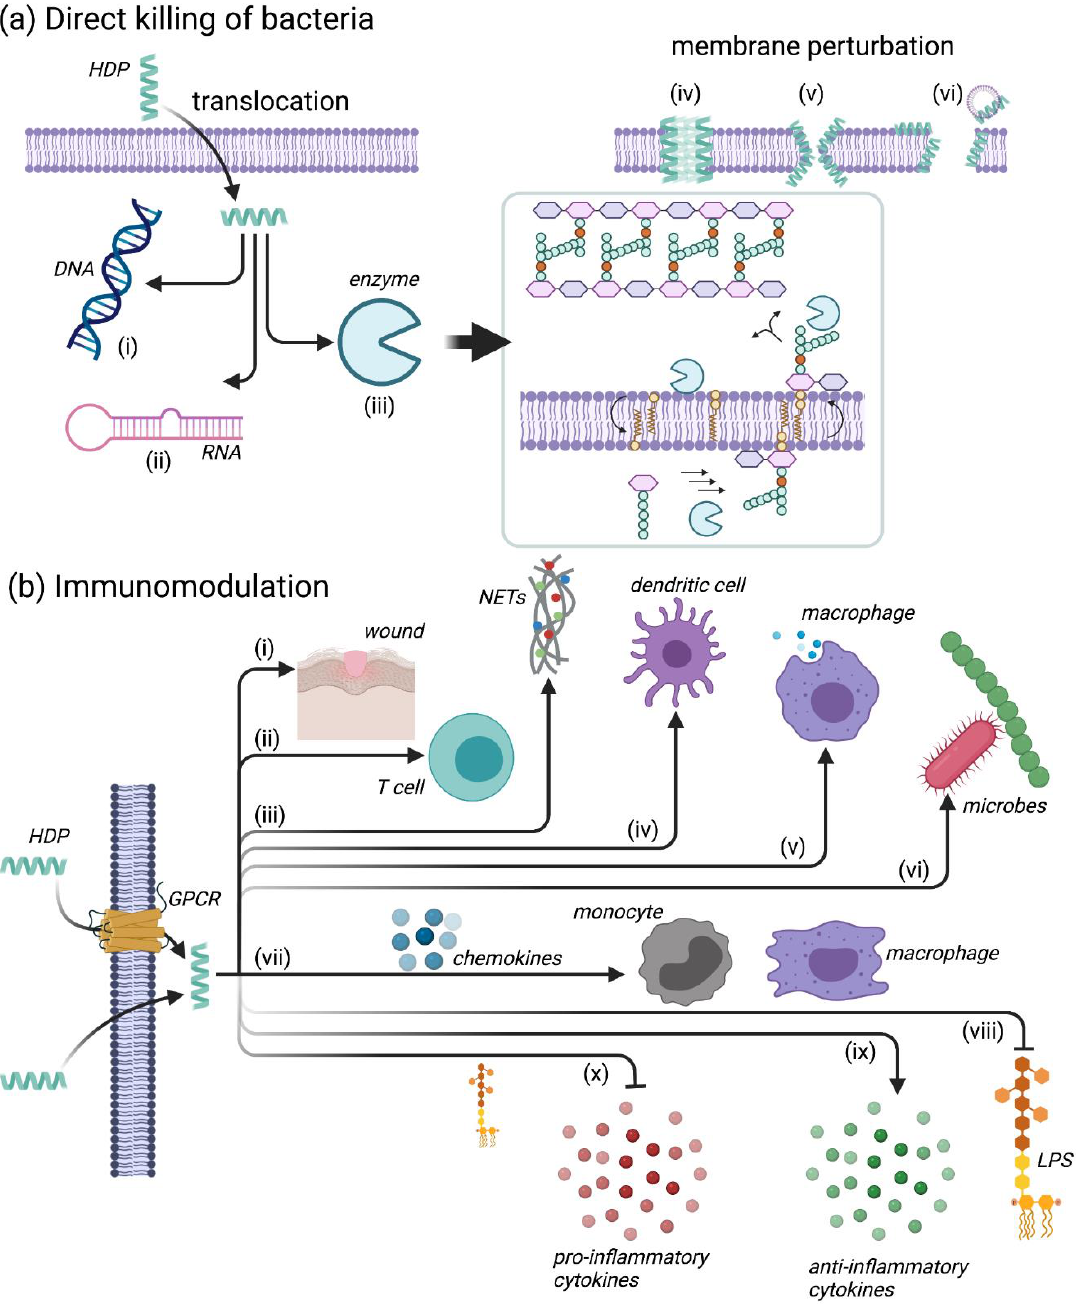
Figure 3. Mechanisms of action of HDPs: ( a ) direct killing of the bacteria, ( b ) immunomodulation. In ( a ), as indicated on the left, HDPs can translocate through the bacterial membrane to reach inner targets, such as (i) DNA, (ii) RNA or (iii) interfere with biosynthetic reactions by binding to proteins or substrates. The inset schematically shows peptidoglycan biosynthesis in S. aureus . HDPs can interfere at different points in this pathway. In ( a ), on the right, direct killing through membrane perturbation is shown. The specific mechanisms here are: (iv) barrel stave, (v) toroidal or (vi) carpet or detergent-like pore formation, which lead to cell lysis. In ( b ), intracellular uptake occurs either through G protein-coupled receptors (GPCRs) (yellow) or direct translocation [40]. Once inside, HDPs can function in a myriad of ways: (i) wound healing, (ii) recruitment and polarization of T cells, (iii) promotion of neutrophil extracellular trap (NET) release, (iv) differentiation of dendritic cells, (v) phagocytosis, (vi) modulation of the host microbiome, (vii) induction of chemokines (blue), which leads to the recruitment of monocytes (grey) and macrophages (purple), (viii) neutralization of lipopolysaccharide (LPS), (ix) induction of anti-inflammatory cytokines and (x) suppression of LPS-induced pro-inflammatory